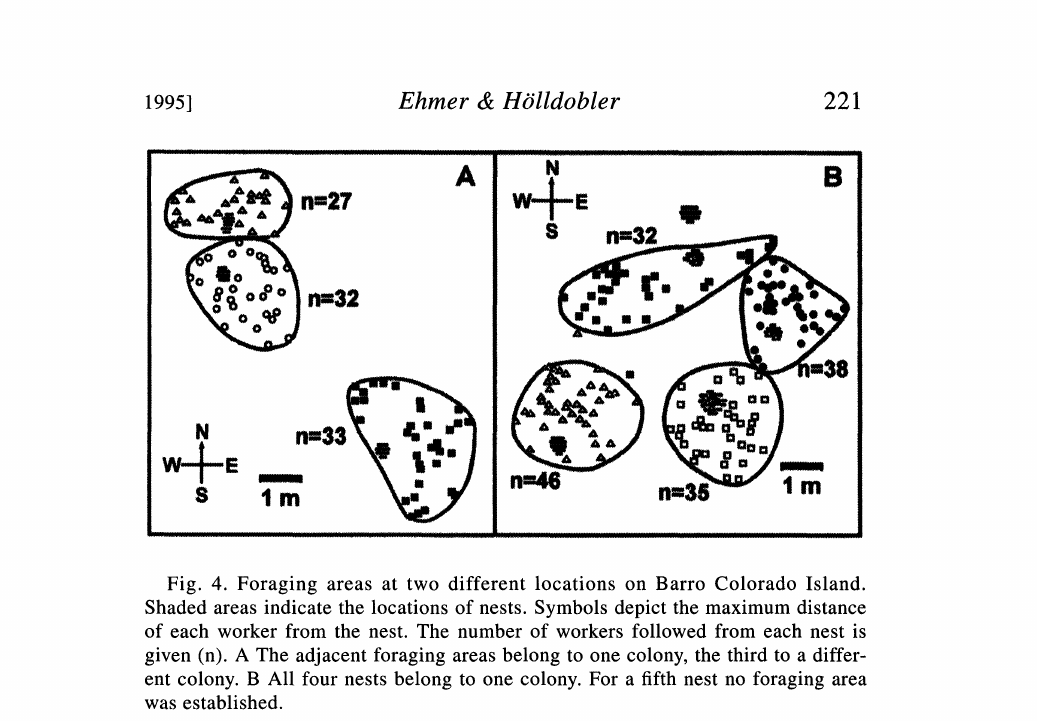
Fig. 4. Foraging areas at two different locations on Barro Colorado Island. Shaded areas indicate the locations of nests. Symbols depict the maximum distance of each worker from the nest. The number of workers followed from each nest is given (n). A The adjacent foraging areas belong to one colony, the third to a differ- ent colony. B All four nests belong to one colony. For a fifth nest no foraging area was